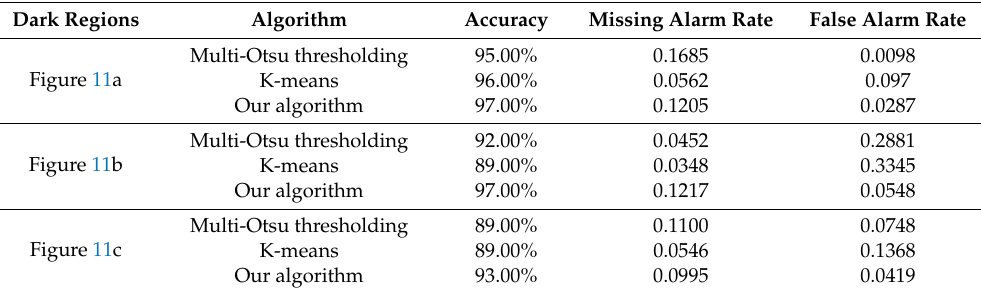
Table 4. Accuracy of the segmentation algorithms.